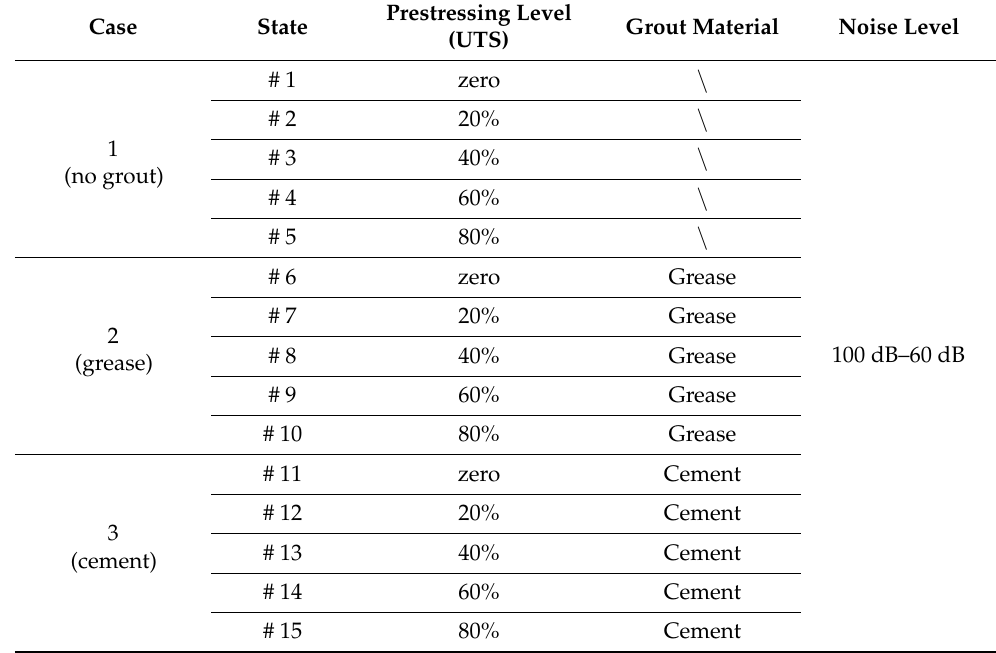
Table 1. Test matrix for computation modeling.